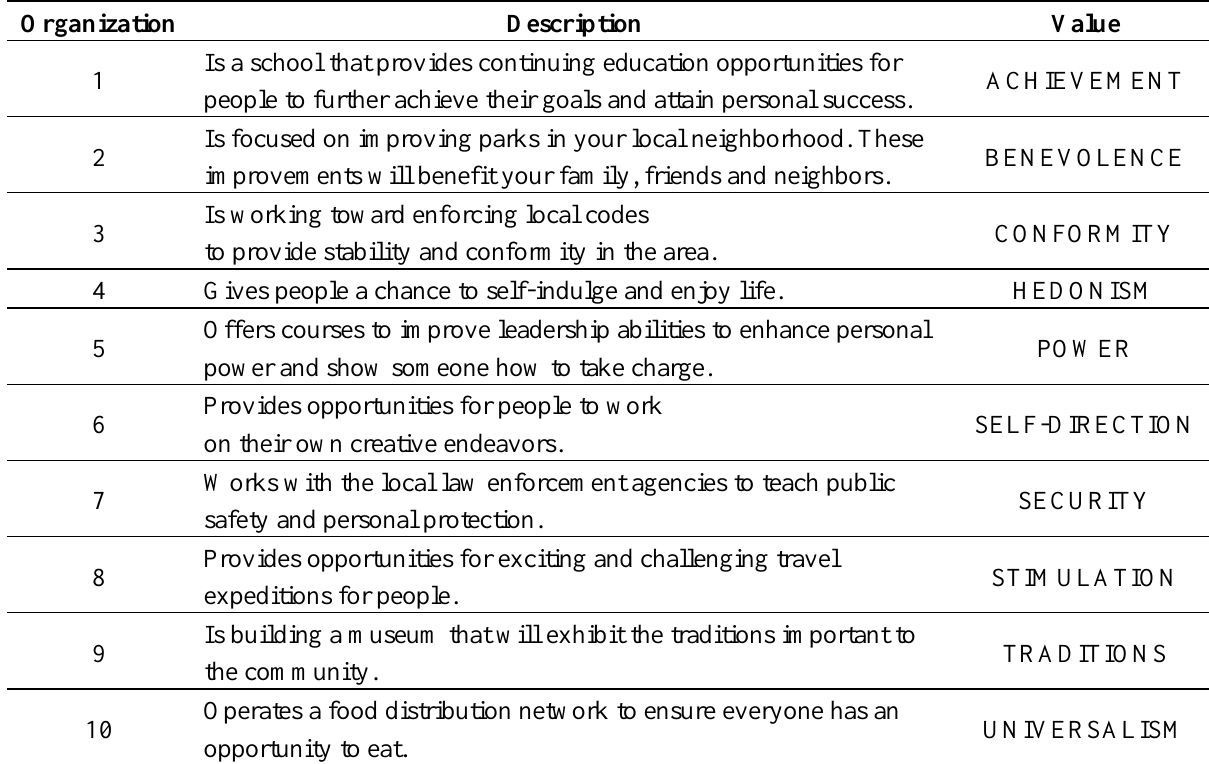
Table 2. Example Allocation by